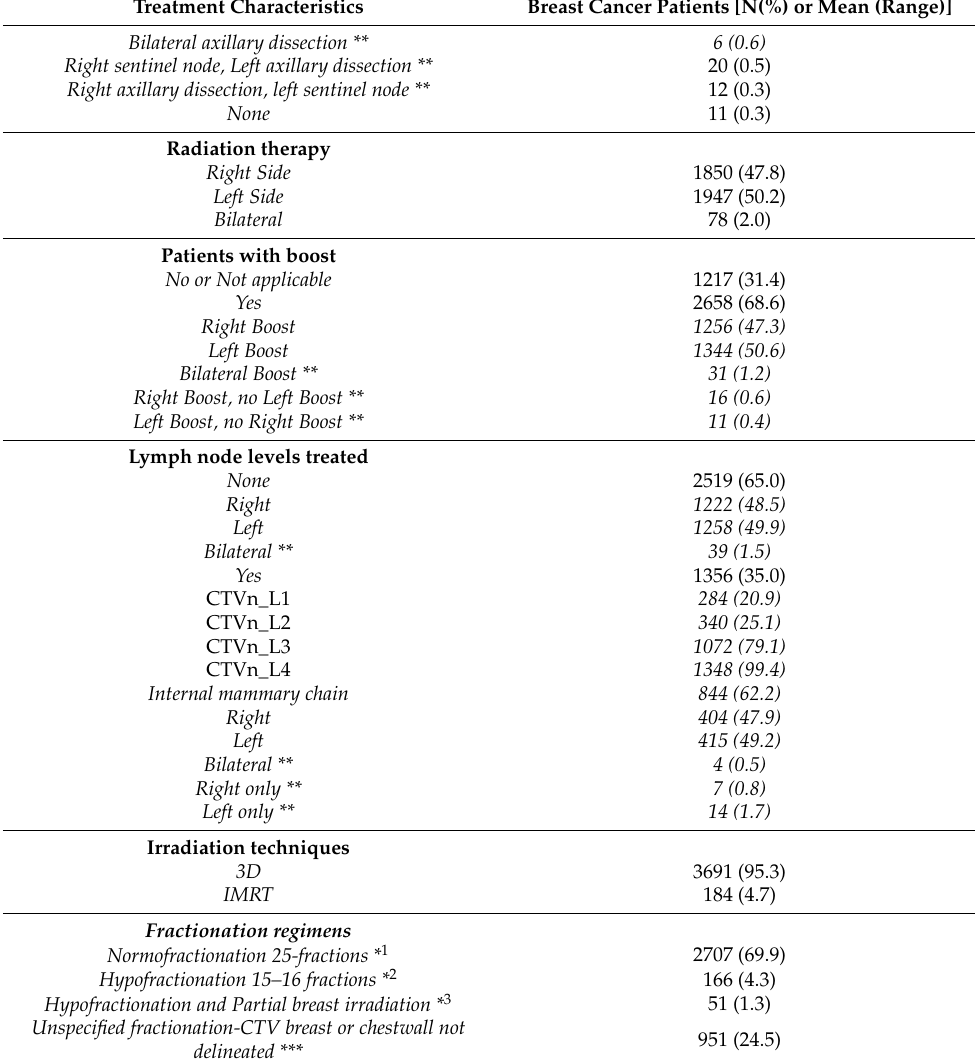
Table 2. Cont. Treatment